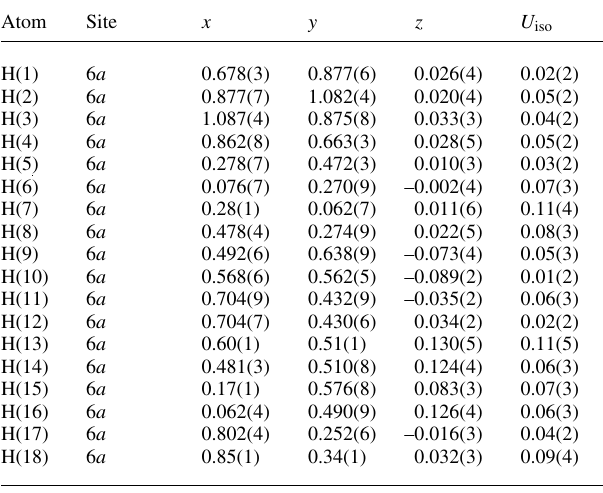
Table 2. Atomic coordinates and displacement parameters (in Å 2 )